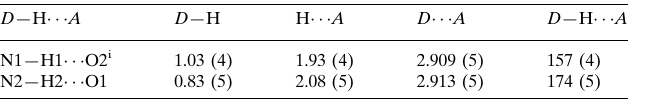
Hydrogen-bond geometry (A˚ , (cid:2)